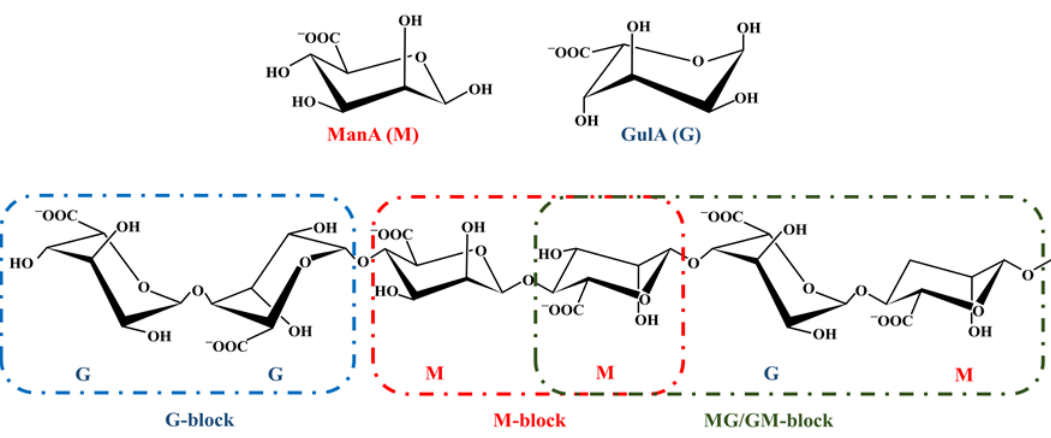
Figure 3. Chemical structure of alginate. The alginate monomers β– D – mannuronic acid (ManA; M) and α– L – guluronic acid (GulA; G), as well as an alginate chain illustrating linkage conformation and block